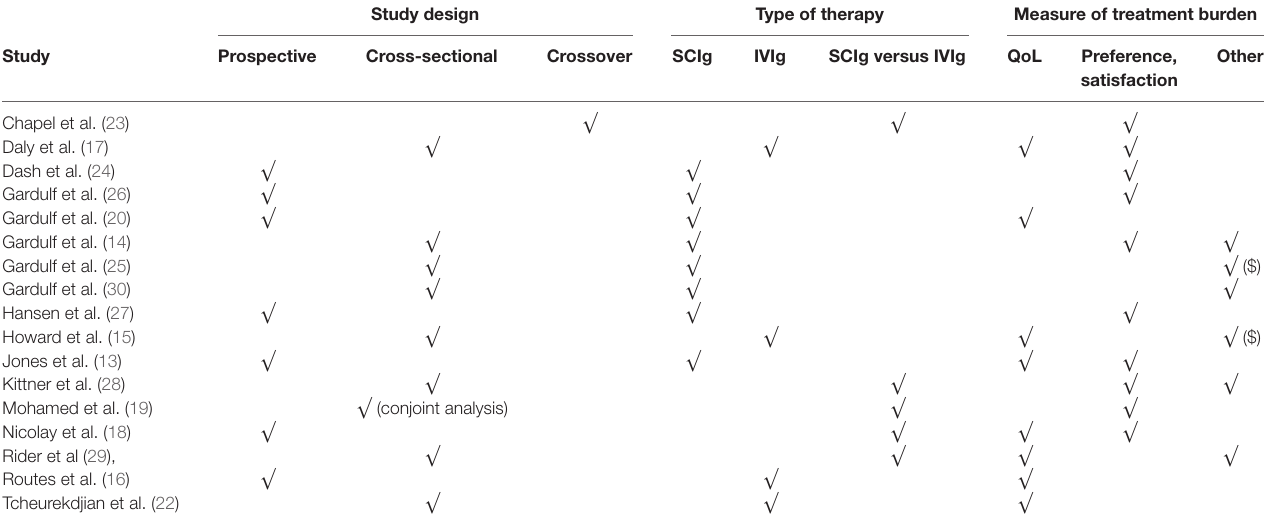
taBLe 1 | Summary table of study